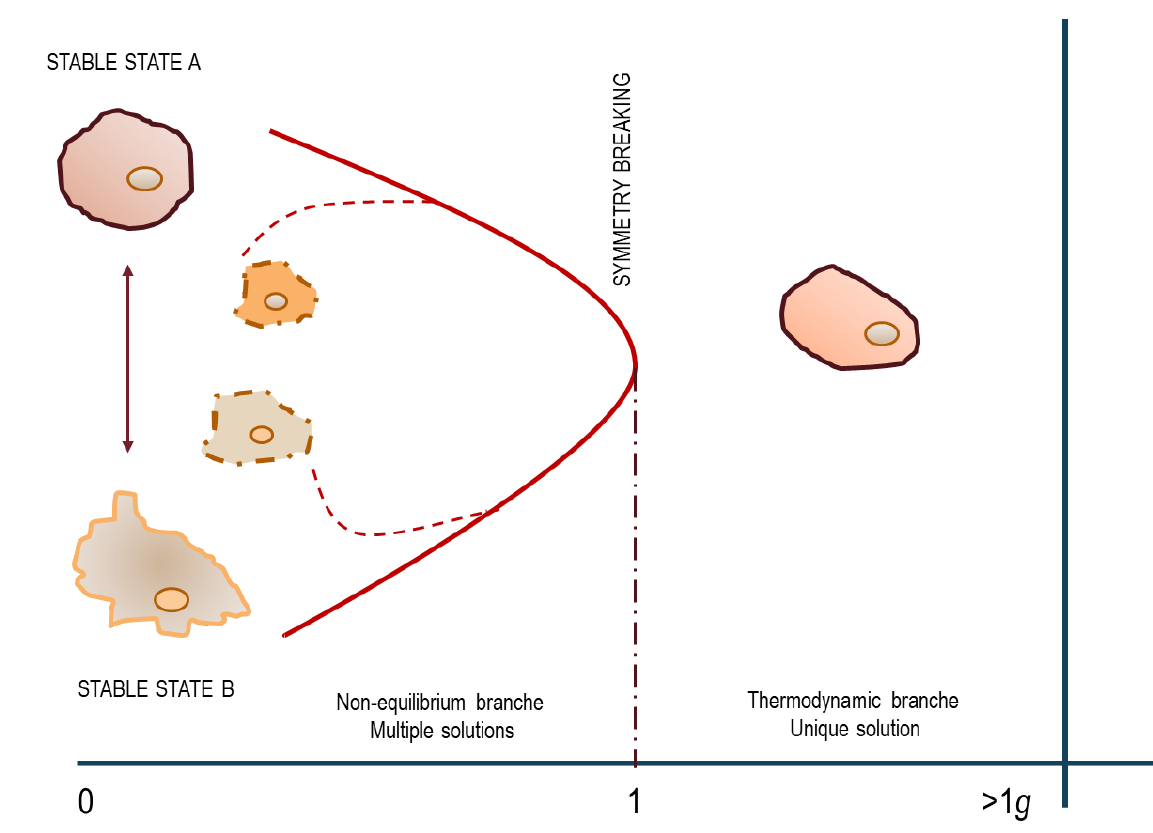
Figure 2. The diagram depicts a system travelling across symmetry breaking, thus alternatively accessing two different regimens, featured by equilibrium and non-equilibrium thermodynamics, respectively. Within the gravity field, the system displays a linear behavior and thermodynamics allows only one stable solution: the fate commitment of the cell(s) is unambiguously (and deterministically) recognizable. Downstream of the bifurcation point, in microgravity, the system recovers its symmetry. The previous thermodynamic state becomes unstable and new configurations arise, some of which are transitory, being unstable or meta-stable. This experiment (adapted from [61]) demonstrated that the presence of even a weak force such as gravity can exert a significant effect upon the evolution of a non-equilibrium process by constraining that evolution into a unique stable,